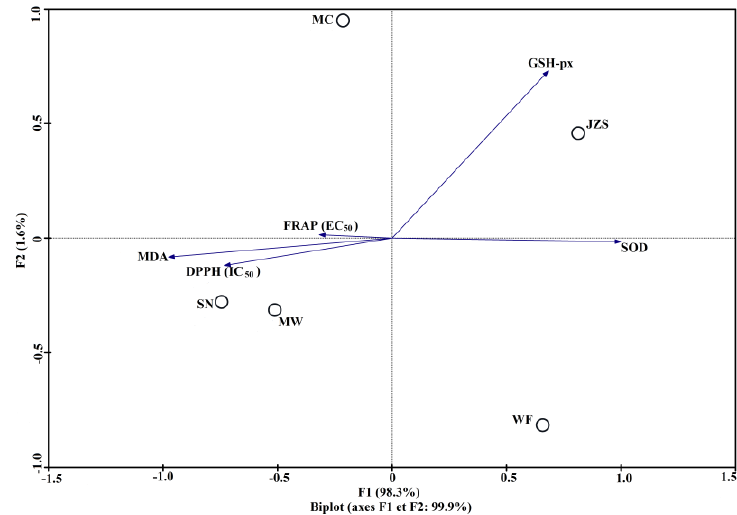
Figure 5. Principal component analysis for studied locations (JZS, MC, WF, MW, and SN) performed on values of both in vitro and in vivo antioxidant indices (Biplot according to the first two axes).